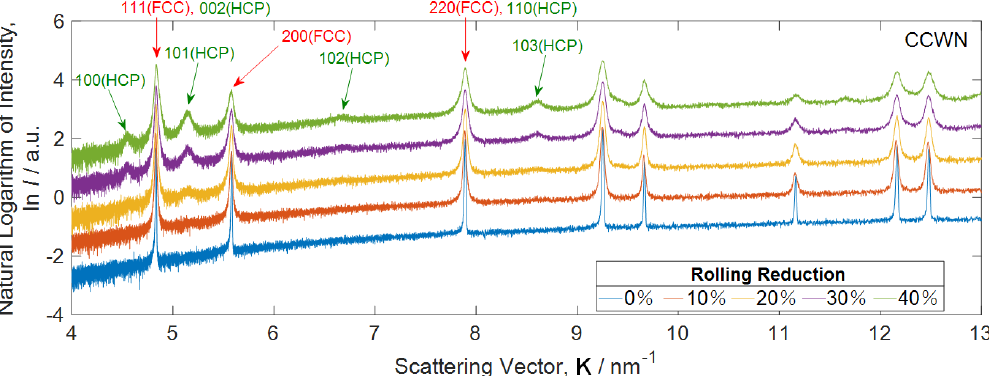
Figure 7. Neutron diffractograms measured by the backscattering bank of iMATERIA for the CCWN alloys at various rolling reductions (K = 1/ d = 2sin θ / λ ).